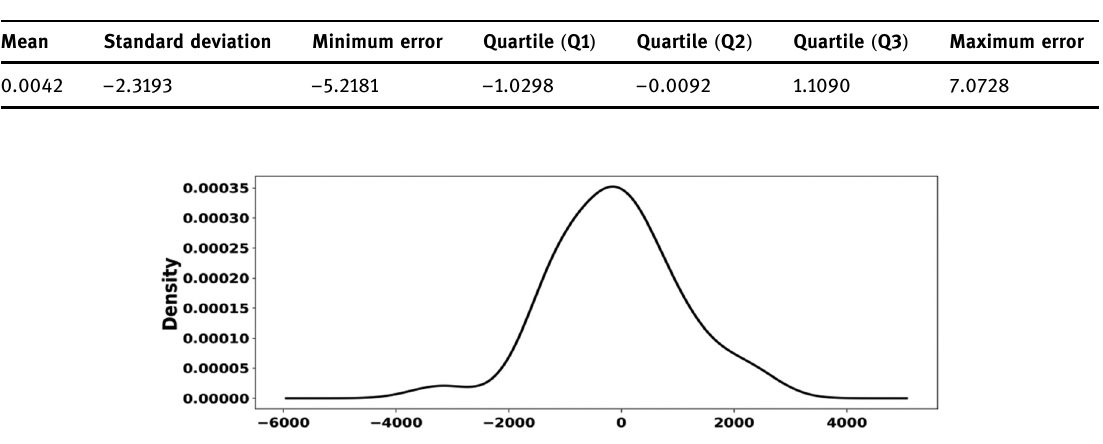
Table 1: Summary statistics of the residual errors